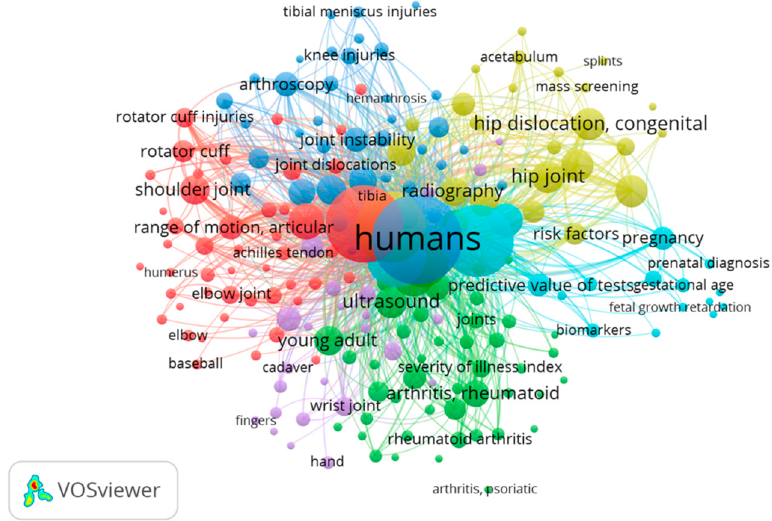
Figure 4. Visualization of keywords for ultrasound examination and joint.